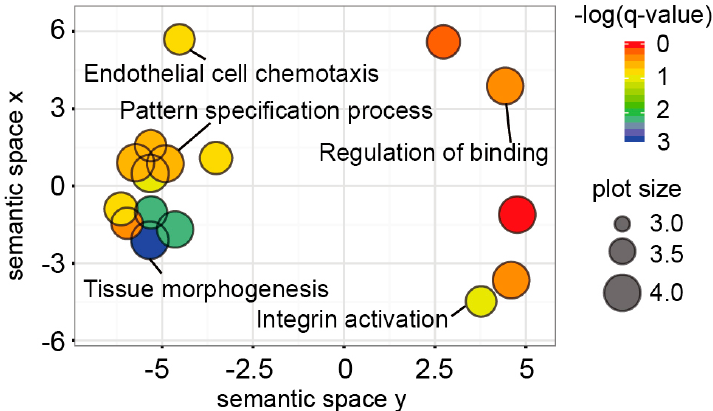
Figure 5. Gene ontology analysis and functional implication of hypermethylated genes in UC. Gene ontology (GO) analysis was performed using GeneMANIA with nearby genes around 48 hypermethylated CpG sites which coincides with CpG islands. The x and y axis represent arbitrary numbers. Similar terms tend to be clustered in the plot. The size of circle depicts whether a given term is a more general GO term ( larger ) or a more specific one ( smaller ).